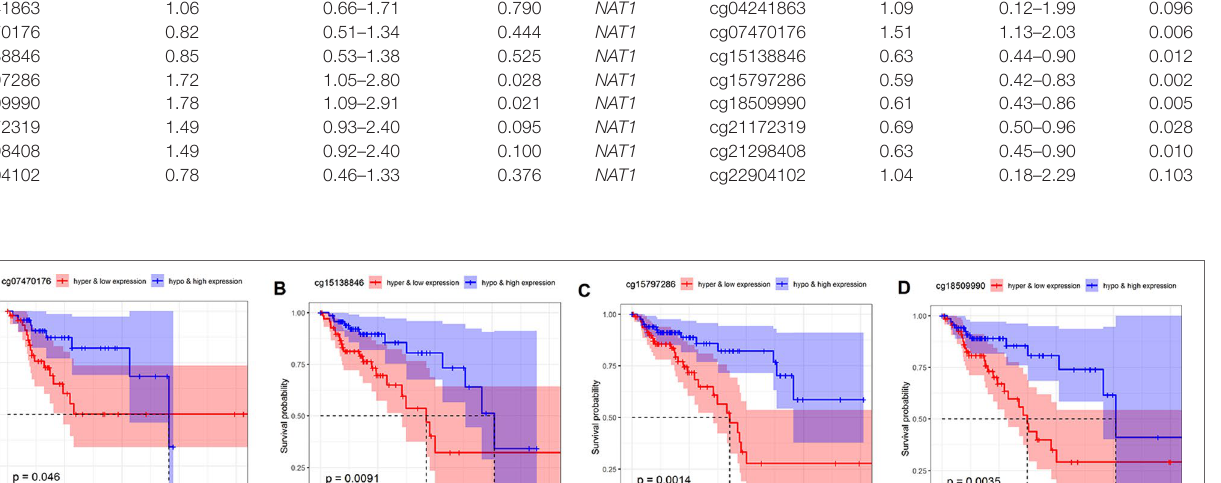
TABle 2 | N - acetyltransferase 1 ( NAT1 ) CpG sites methylation associated with overall survival in colon adenocarcinoma (COAD). CpG sites